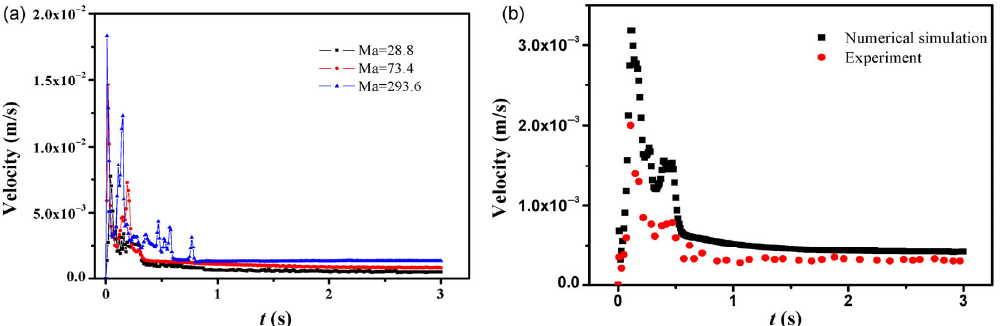
Fig. 3 (a) Silicone-oil migration velocity under different temperature gradients G with Marangoni Ma numbers of 28.8, 73.4, and 146.8. (b) Comparison of computational fluid dynamics (CFD) and experimental results for silicone-oil migration velocity at G = 1.96 K/mm and contact angle θ =